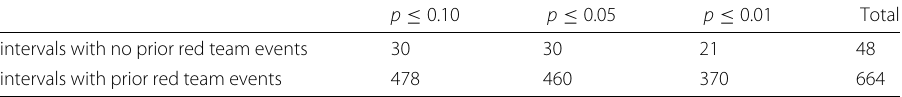
Table 2 Aggregate behavior of temporal scoring on a per event basis p ≤ 0.10 p ≤ 0.05 p ≤ 0.01 Total intervals with no prior red team events 30 30 21 48 intervals with prior red team events 478 460 370